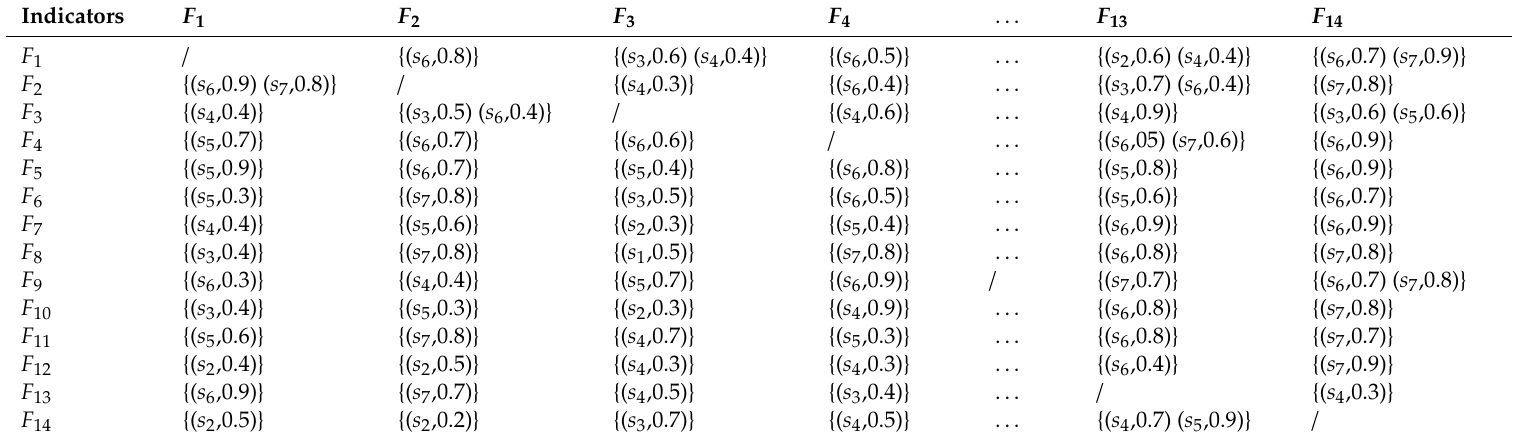
Table 2. Individual interrelationship evaluation matrix of the first expert.